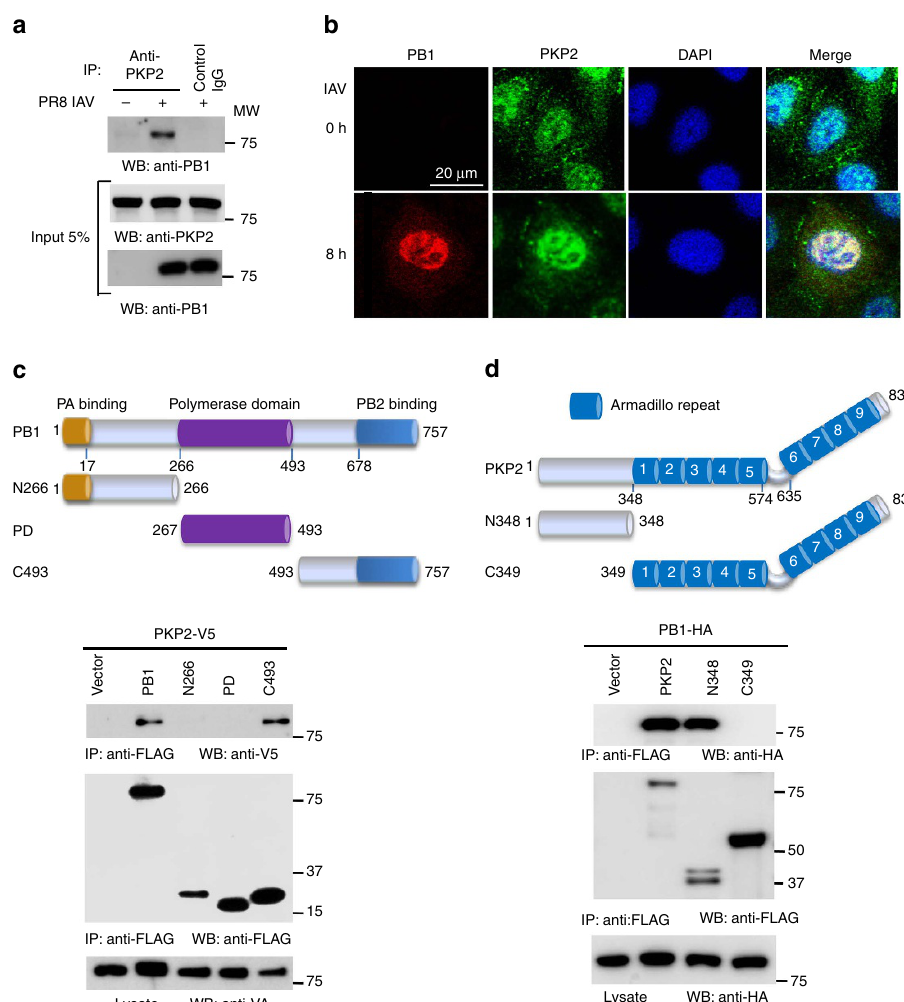
Figure 3 | PKP2 interacts and co-localizes with PB1. ( a ) Primary human tracheal epithelial cells were infected with 1 MOI of PR8 IAV for 16h. Cell lysates were subjected to immunoprecipitation and immunoblotting with the indicated antibodies to detect endogenous interactions. Molecular weights (MW) are indicated. ( b ) A549 cells were infected with 1 MOI of PR8 IAV for 8h and stained with anti-PKP2 (green), anti-PB1 (red) and DAPI nuclear stain (blue). ( c ) Full-length and various PB1 deletion mutants were fused with FLAG epitope and co-transfected with PKP2-V5 into HEK293 cells. Lysates were immunoprecipitated with anti-FLAG antibody and blotted with the indicated antibodies. ( d ) Full-length and various PKP2 deletion mutants were fused with FLAG epitope and co-transfected with PB1-HA into HEK293 cells. Lysates were immunoprecipitated with anti-FLAG antibody and blotted with the indicated